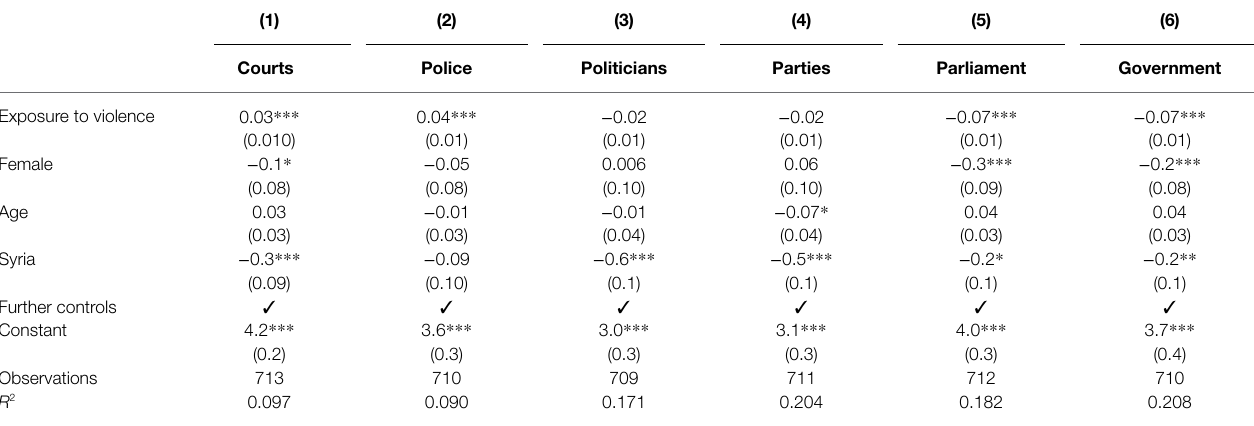
TABLE 5 | Exposure to violence and institutional trust in the settlement country with